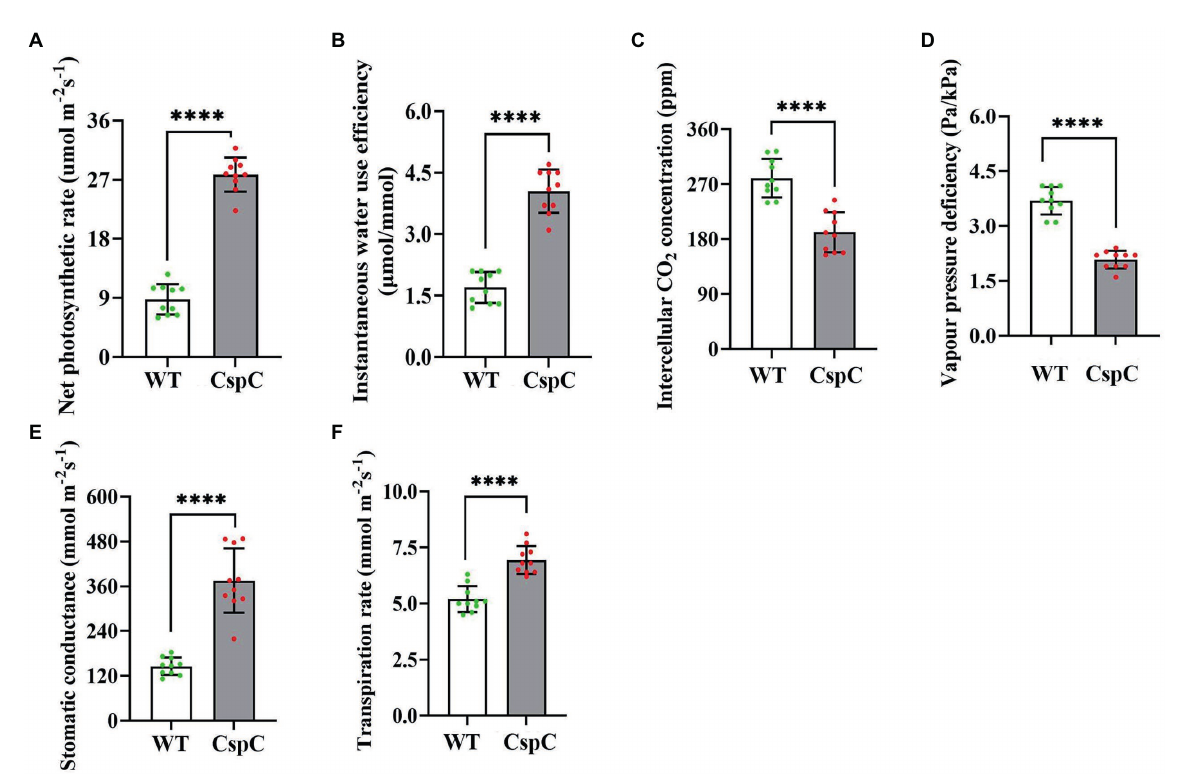
FIGURE 6 Photosynthetic efficiency of DgCspC overexpression cotton. (A) Net photosynthetic rate; (B) instantaneous water use efficiency; (C) intercellular CO 2 concentration; (D) vapor pressure deficiency; (E) stomatal conductance; (F) transpiration rate. Asterisks indicate significant differences between WT and the OE-C-1/ OE-C-2 transgenic lines. (**** p < 0.0001 for comparisons between the transgenic lines and wild-type plants by Student’s t -tests).